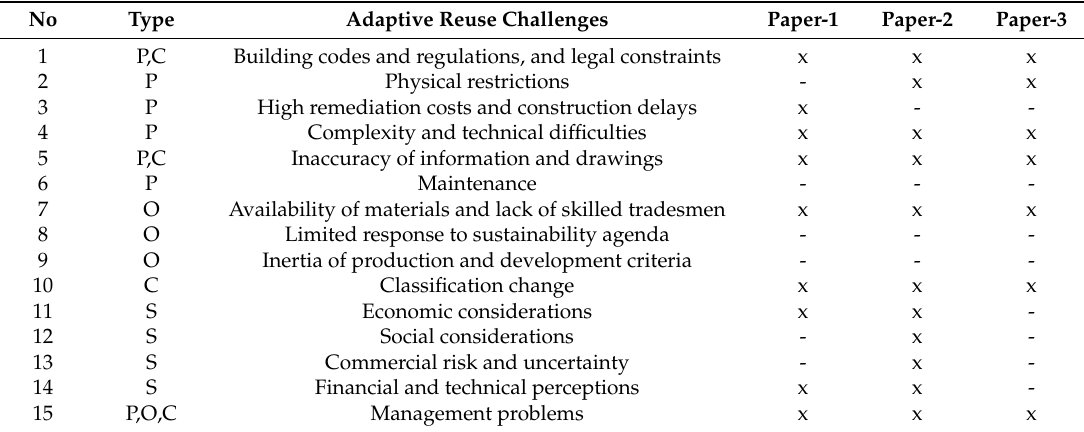
Table 1. The comparison of adaptive reuse barriers to common interface